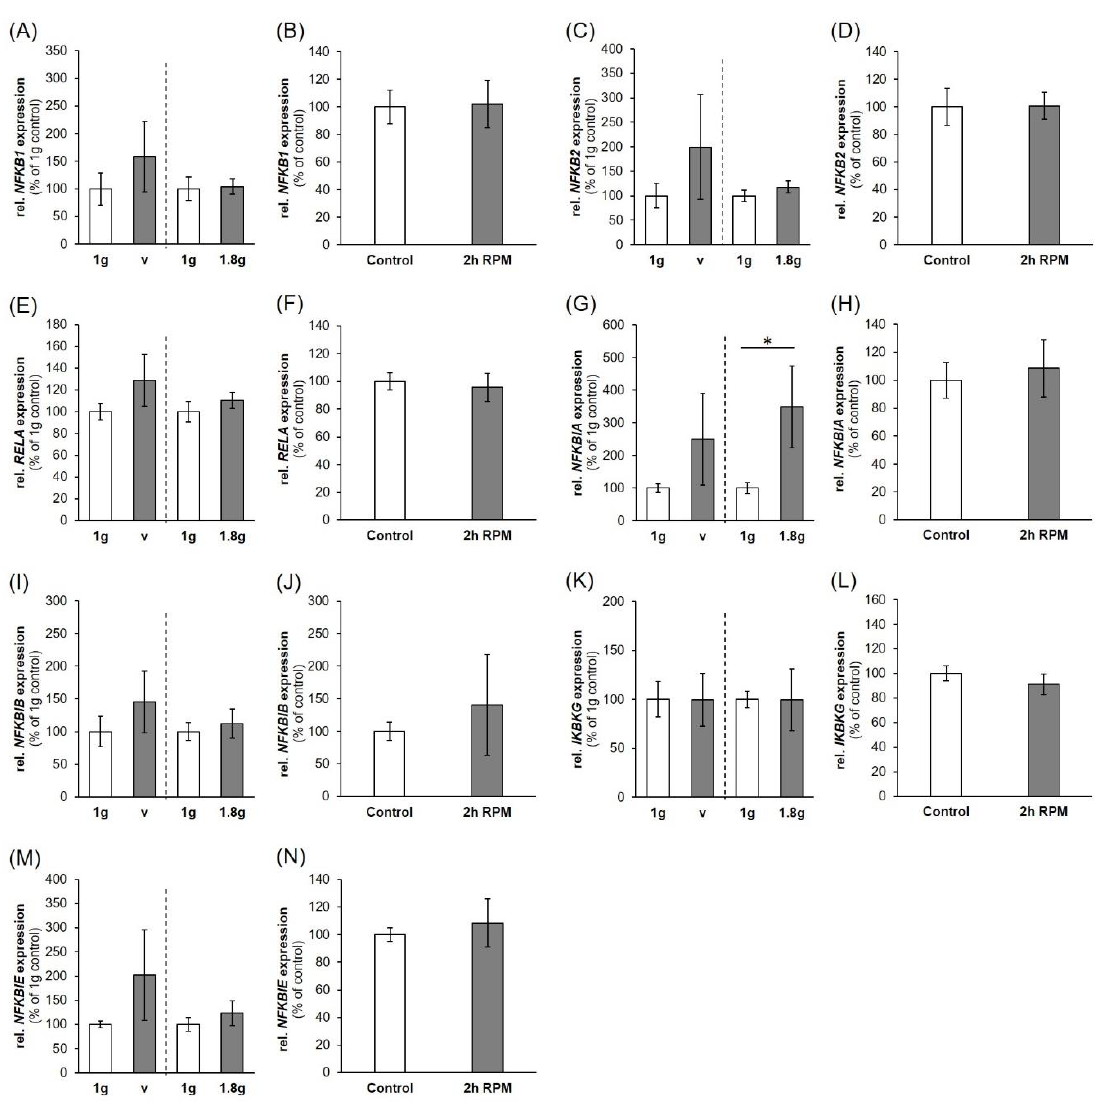
Figure 3. Influence of VIB (V), hyper- g and iRPM-exposure on the gene expression of NF- κ B signaling factors: ( A , B ) NFKB1 , ( C , D ) NFKB2 , ( E , F ) RELA , ( G , H ) NFKBIA , ( I , J ) NFKBIB , ( K , L ) IKBKG , ( M , N ) NFKBIE . n = 5. The data are given as mean ± standard deviation. * p < 0.05 vs. corresponding 1 g -controls. The dashed vertical line seperates two independent experiments.